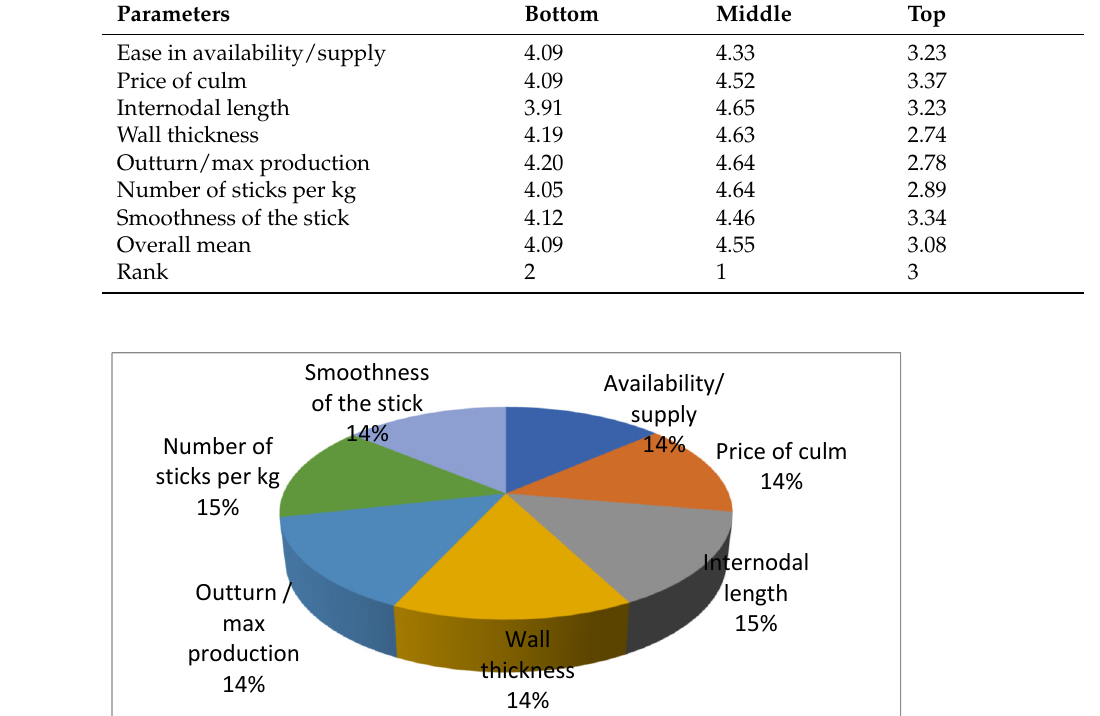
Table 3. Scores and ranking of preferential attributes from questionnaire survey for choice of the portion of the culm used in incense stick industry.